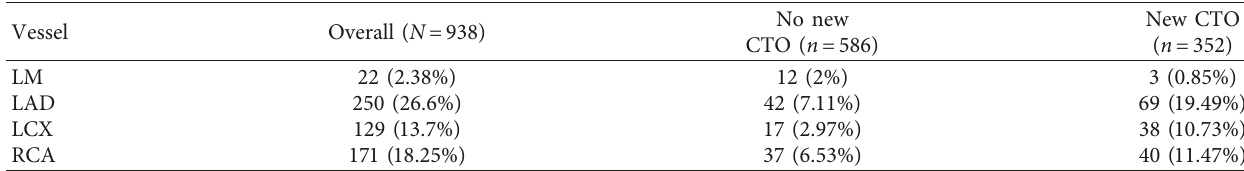
Table 5: Disease progression in native